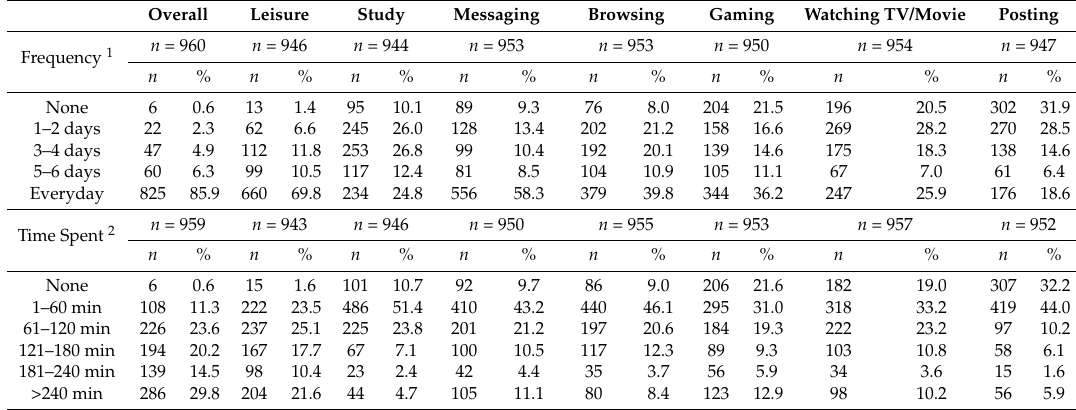
Table 2. Percentages of frequencies and time spent on smart device activities, overall use and its purposes. Overall Leisure Study Messaging Browsing Gaming Watching TV/Movie Posting